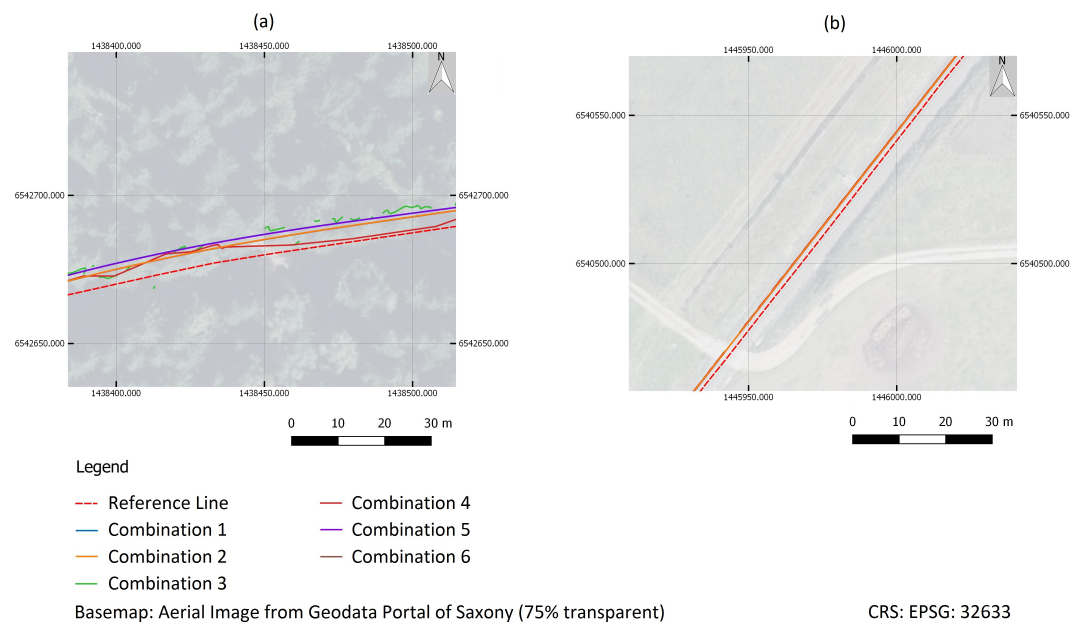
Figure 9. Map of result of all combinations and the reference line in ( a ) tree-covered area (result from combinations 1 and 5 as well as 2 and 6 are similar in this section of the track) and, ( b ) area with no obstructions (result from all combinations are similar in this section of the